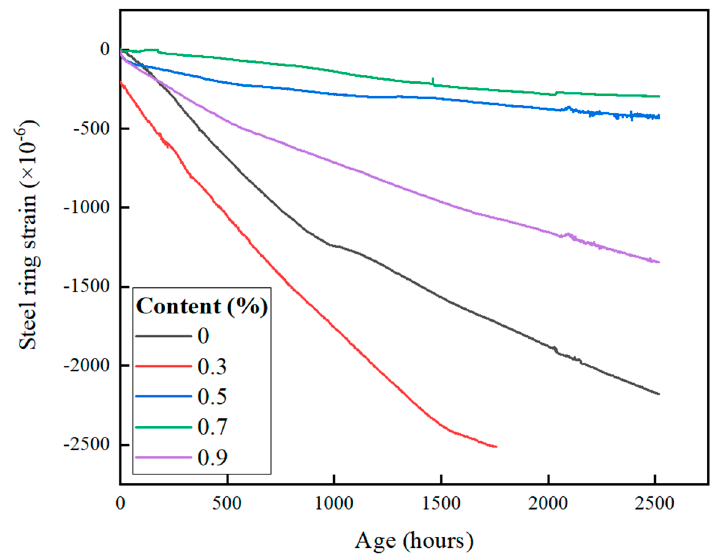
Figure 10. Steel ring strain of GGBFS geopolymers with ST added.